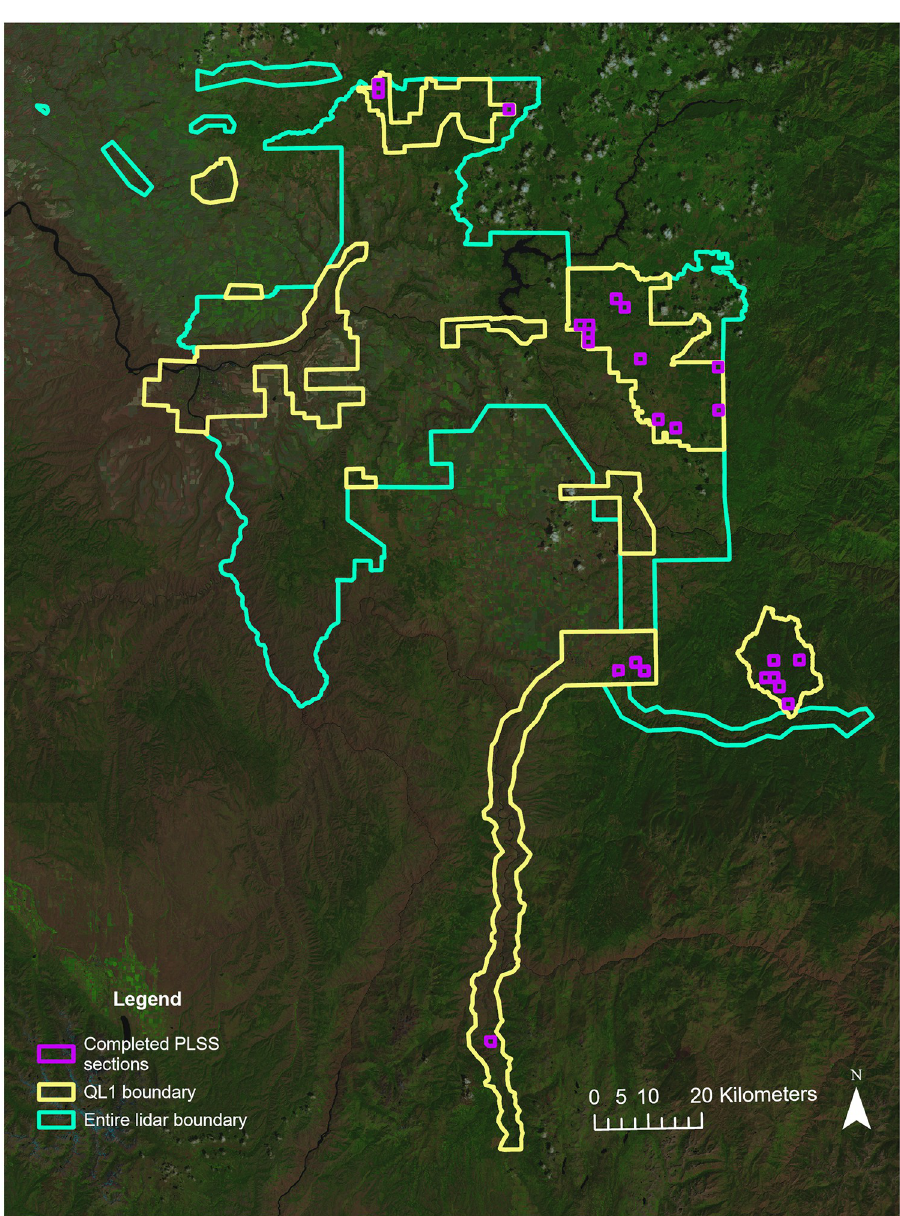
Fig 1. Map of the area covered by the entire Clearwater–Nez Perce 3DEP 2016 lidar acquisition, highlighting the QL1 data boundaries and the 24 randomly-selected PLSS sections. Background map is a composite of Landsat